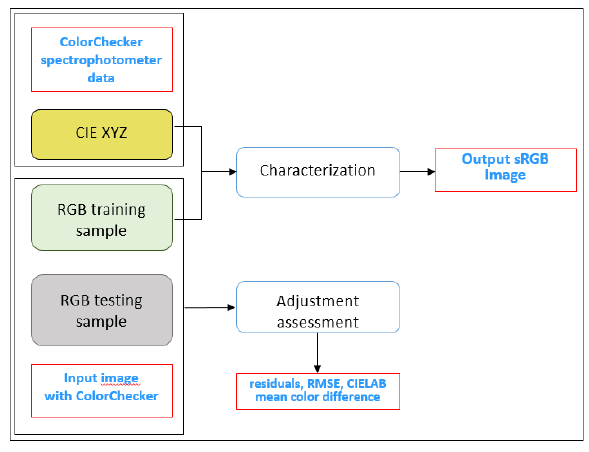
Figure 5. Digital camera characterization